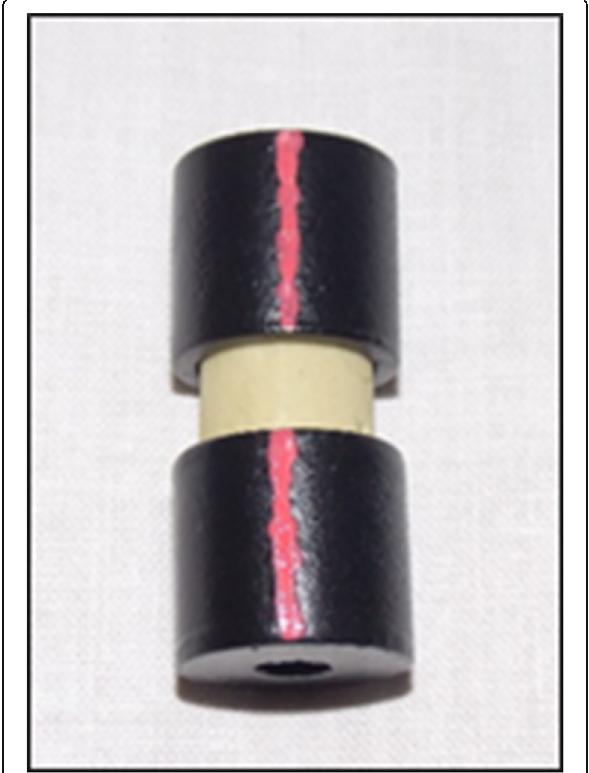
Fig. 2 The placement of the specimen in the metallic mold